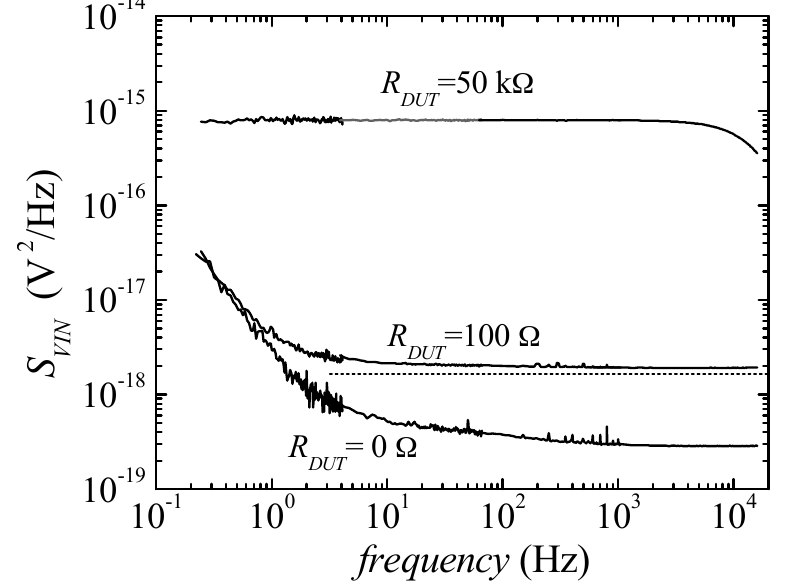
Figure 9. Referred noise obtained dividing the noise at the output V O 1 by the calibrated gain squared. In the case of R DUT = 100, the measured noise is above the ideal one because at these low levels of noise, the background noise (BN) is no longer negligible.